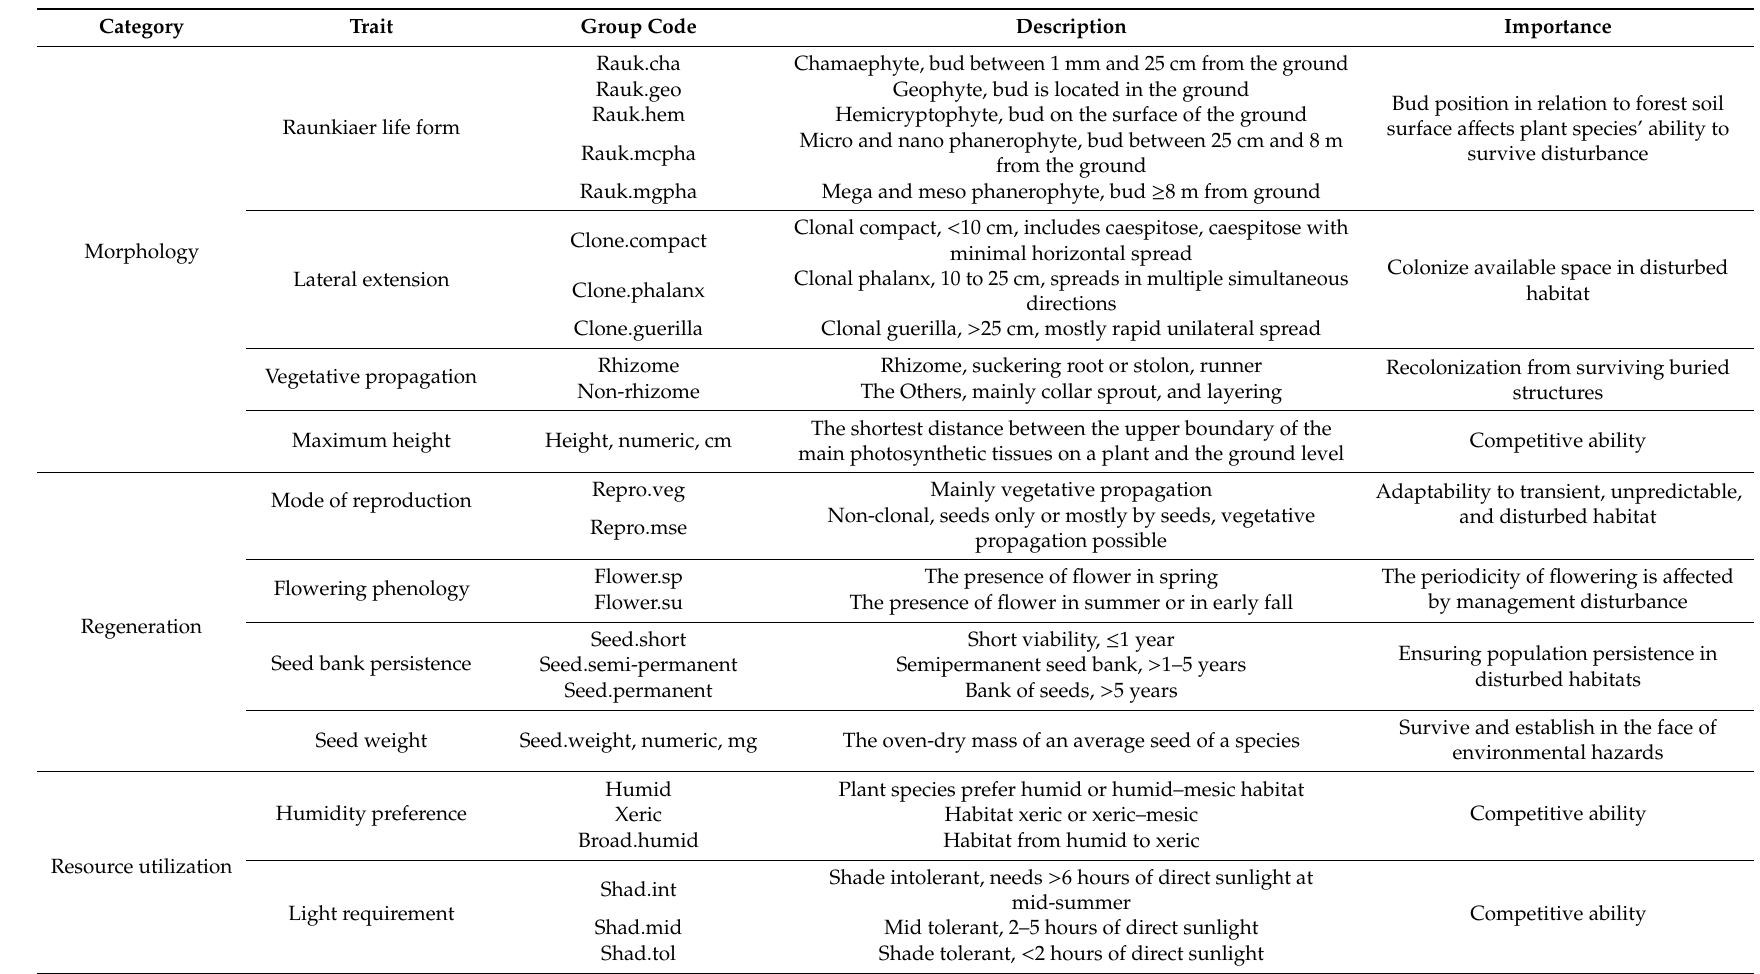
Data source: TOPIC database, Traits of Plants in